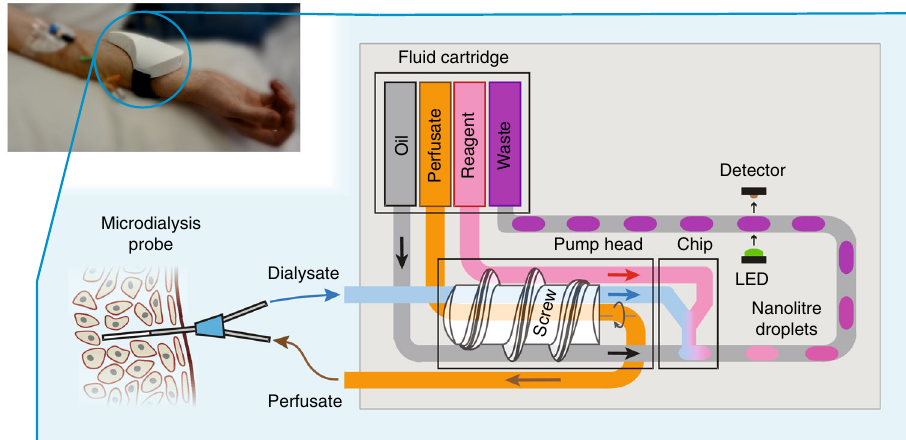
Fig. 1 Schematic diagram illustrating the operation of the device. The screw-driven peristaltic pump simultaneously feeds perfusate into a microdialysis probe and withdraws the resulting dialysate into the device. From the pump, dialysate is delivered into a micro fl uidic chip, where an analyte-speci fi c reagent is added, and the resultant fl ow immediately segmented into a stream of droplets by the addition of an immiscible oil. Within the droplets, the reagent reacts with the analyte to produce a measurable optical response. The droplets fl ow out of the chip into low-volume PTFE tubing and downstream to an optical fl ow cell where the product of the reaction is quanti fi ed 31 . A microcontroller (not shown) saves the result to a micro SD card and relays it via Bluetooth to an external device. The analysed droplets are collected in a waste sachet for later disposal. An image illustrating a sensor being used in a clinical setting to monitor tissue is shown